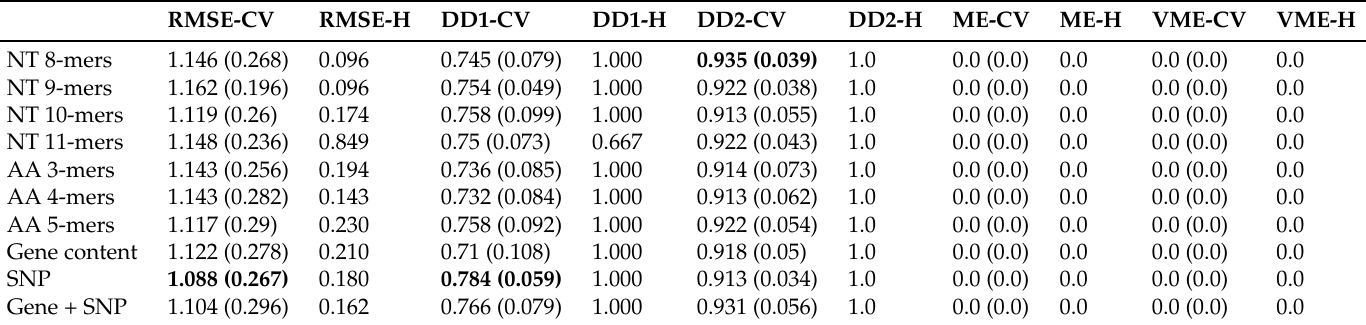
Table A27. N. gonorrhoeae –cefpodoximeproxetil.